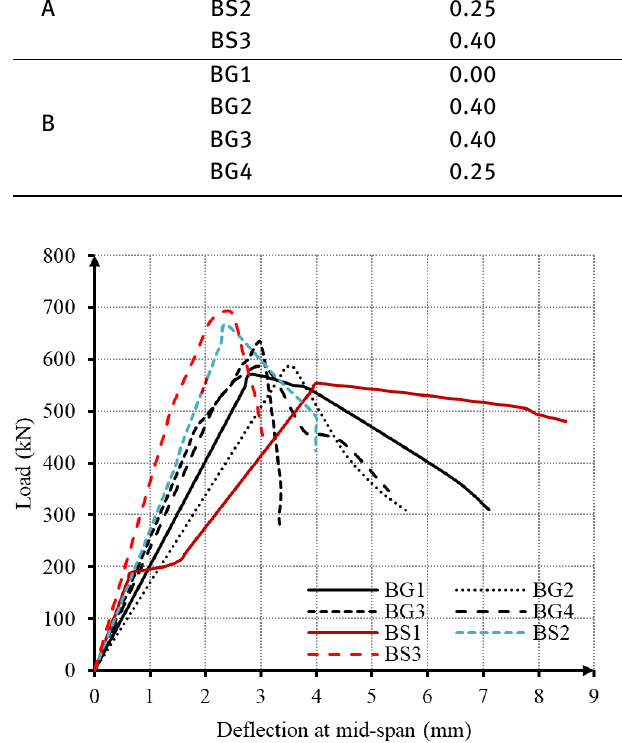
Figure 6: Load-deflection curve for deep beams